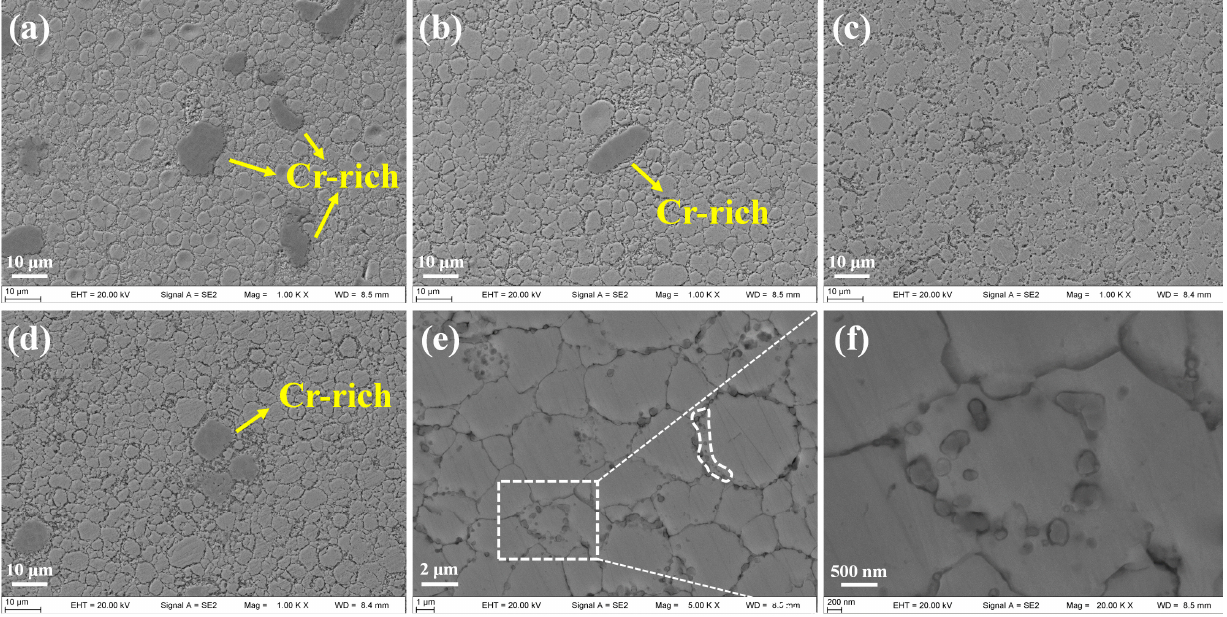
Figure 12. SEM images of sintered specimens: ( a ) A1, ( b ) A2, ( c ) A3, and ( d ) A4; ( e ) and ( f ) Precipitates of